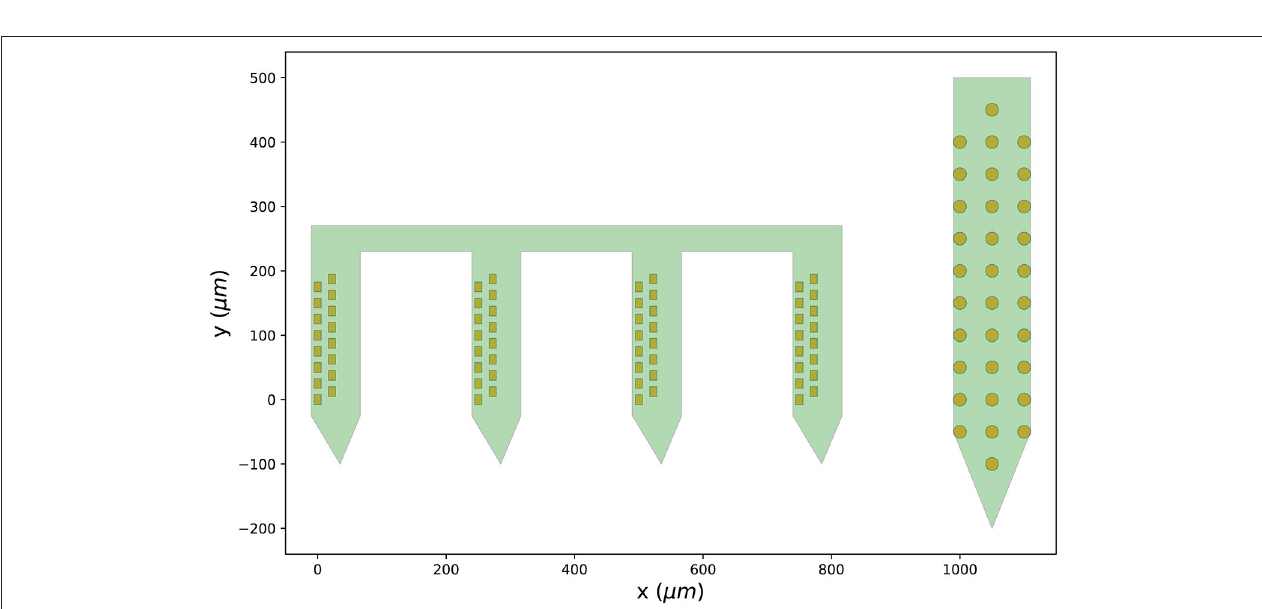
However, there is still a required step in order to map the recorded signals to the probe contacts: wiring